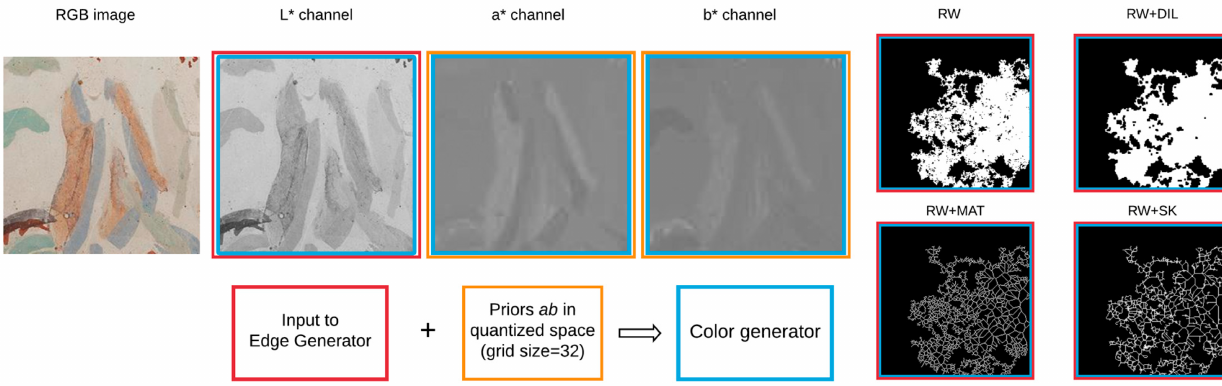
Figure 2. Our model converts the RGB images to L*a*b* color. The edge generator receives as input only the monochrome luminance channel and the binary masks of missing pixels (that follow variations of a random walk pattern). Subsequently, color rarity weights are computed on the a* and b* channels and then used in the loss function of the color generator. The edge map, the multichannel L*a*b* image and the priors are fed to the color